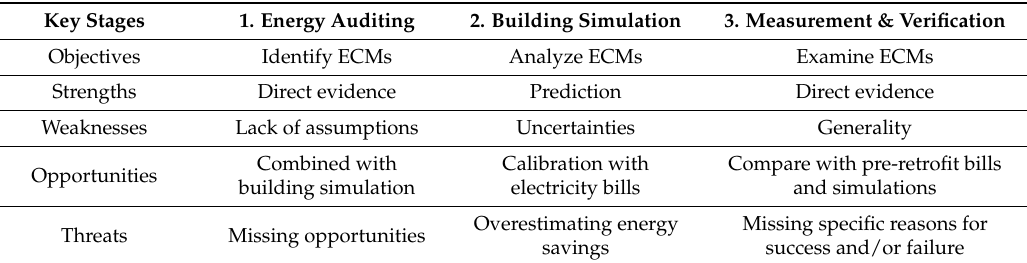
Table 11. SWOT analysis of the key retrofitting